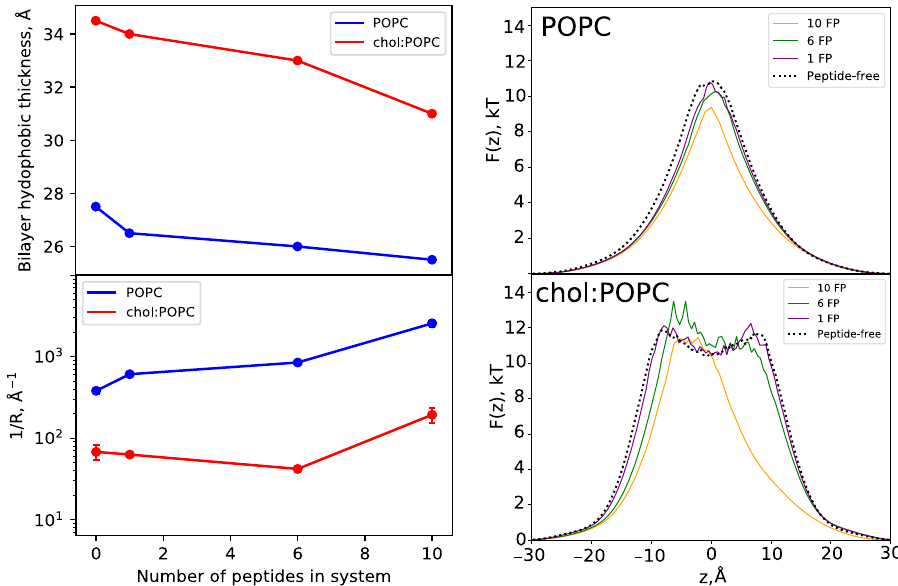
averages for all systems, except for the peptide-free cases where 100ns block averages were used. Error bars are smaller than the symbols for some systems. Right) Free energy F ( z ) (Eq. 6) for water as a function of position along the mem- brane normal for pure POPC (top) and 1:1 chol:POPC (bottom). Source data are provided as a Source Data fi le.